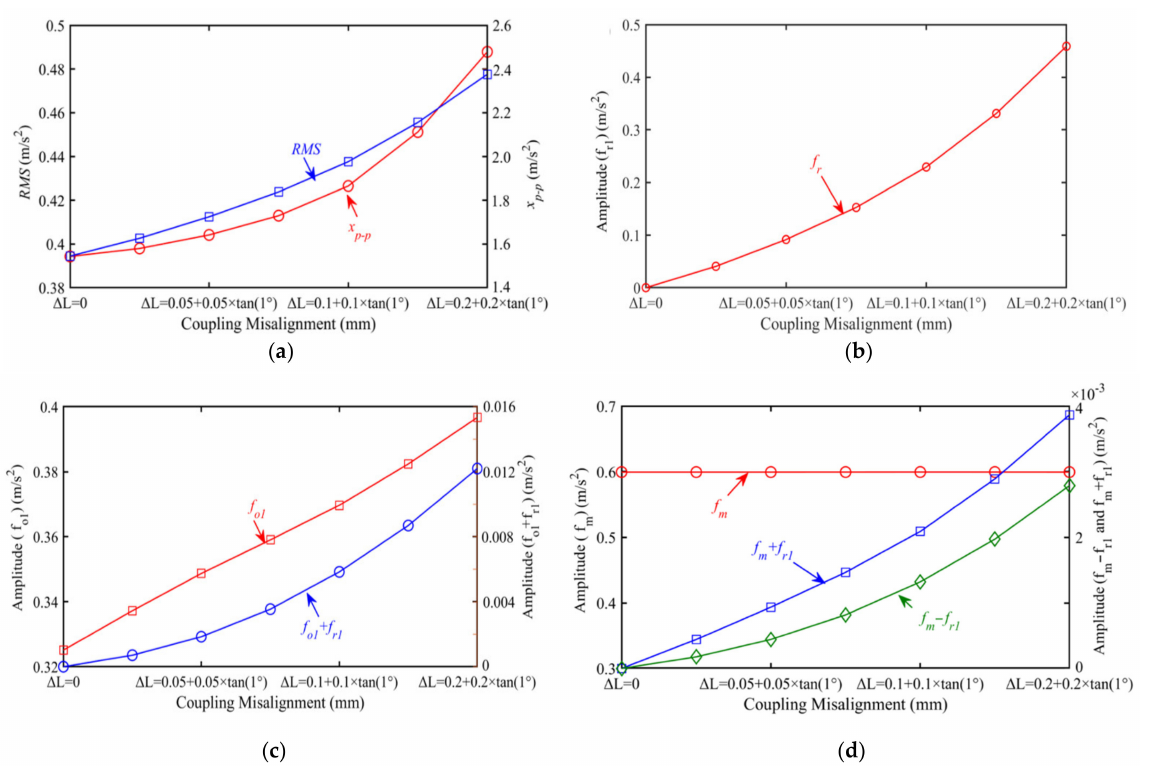
Figure 9. Indicators for vibration characteristics of the bearing-rotor-gear system with the misaligned rotor: ( a ) RMS and x p-p ; ( b ) amplitudes of f r 1 ; ( c ) amplitudes of f o 1 and f o 1 + f r 1 ; ( d ) amplitudes of f m and f m ± f r 1